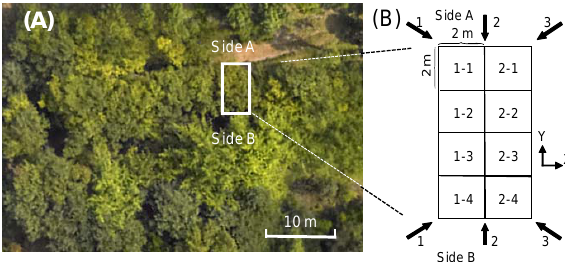
Figure 2: Study area. (A): Aerial photograph (B): A measurement plot established beneath the zelkova canopy. Arrows in (b) show the directions in which lidar scanning was performed (modified from Hosoi and Omasa, 2007).